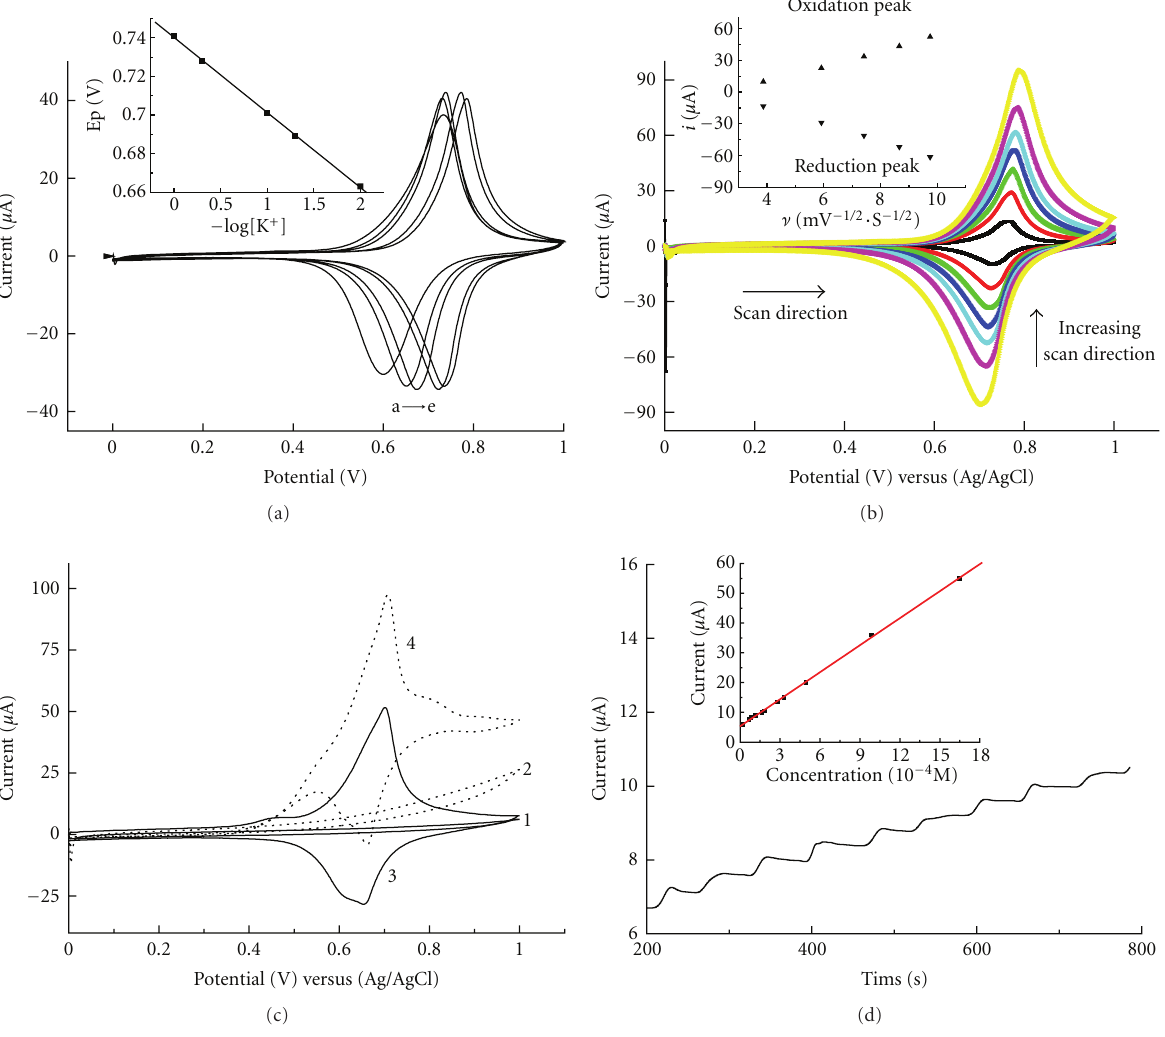
Figure 2: (a) Dependence of the cyclic voltammetric response at a CuHCF modified glass carbon paste electrode on concentrationsof K + : (a) 0.01, (b) 0.05, (c) 0.1, (d) 0.5, and(e) 1 M respectively in KNO 3 bu ff er. Insert: plot of Ep versus − log [K + ]. (b) Cyclic voltammetric responses of CuHCF modified electrodes at various scan rates from 15 to 145mV/s recorded in pH 7 PBS. Inset: Plot of oxidation peak current and the reduction current for CuHCF modified electrodes against the square root of scan rate. (c) Cyclic voltammograms (1) at a bare glassy carbon paste, (2) bare glassy carbon paste in 66 μ M hydrazine in pH 7 PBS, (3) at CuHCF /GCE electrode and (4) CuHCF/GCE electrode in 66 μ M hydrazine. Scan rate: 50mV/s; (d) Chronoamperometric curves of the modified electrodes upon additions of hydrazine in PBS (pH 7) at + 0.72V. Insert: The relationship between current response of CuHCF/GCE and hydrazine